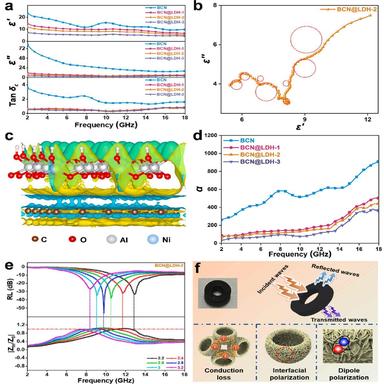
(a) Frequency dependence of the real permittivity, imaginary permittivity and dielectric loss tangent for BCN, BCN@LDH-1, BCN@LDH-2, and BCN@LDH-3. (b) Cole-Cole plot and of BCN@LDH-2. (c) Differential charge density map of BCN/LDH. (d) Attenuation constant of BCN, BCN@LDH-1, BCN@LDH-2, and BCN@LDH-3. (e) The 2D reflection loss and impedance matching of BCN@LDH-2. (f) The mechanisms of EMW absorption in BCN@LDH-2.